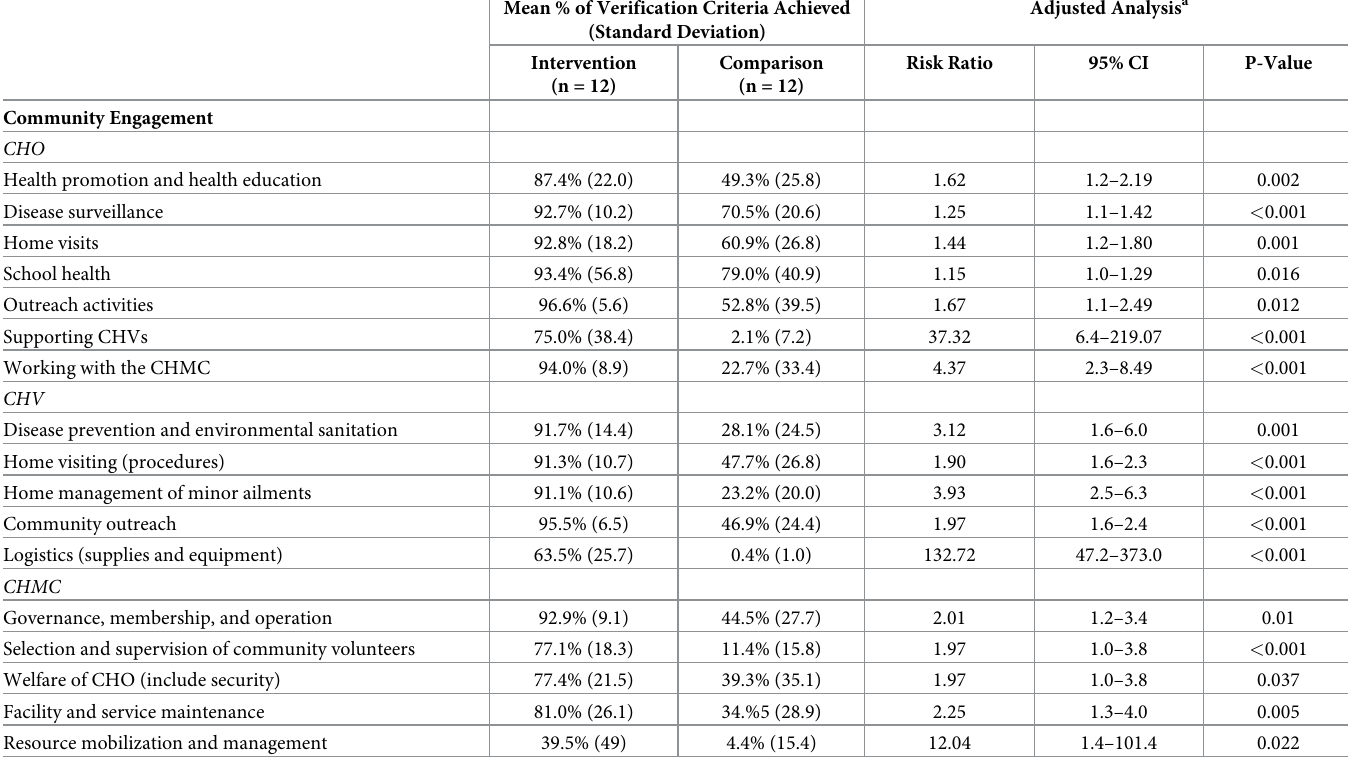
Table 4. Multivariate analyses of percentage of verification criteria achieved for community engagement assessment